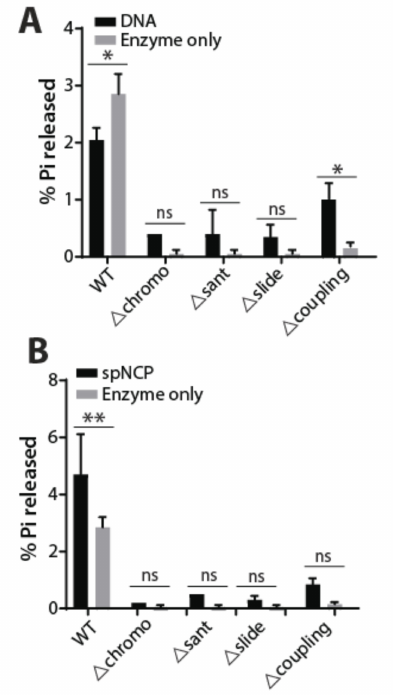
Figure 3. ATPase activities for wild type and Hrp3 mutants with DNA and nucleosome substrates: WT or mutant Hrp3 (30 femto moles) were used for ATP hydrolysis with DNA ( A ) or S. pombe nucleosomes ( B ). The y -axis shows the percentage of inorganic phosphate (Pi) released upon ATP hydrolysis by WT or mutant Hrp3. Graphpad Prism was used to plot the graphs and to calculate the significance of the catalytic activity using 2way ANOVA. For comparison between DNA-enzyme alone for WT and ∆ coupling region are 0.018 and 0.0118, respectively, while for spNCP-enzyme alone the significance value was 0.0068. The significance was calculated from two biological replicates. Other comparisons did not give significance and are marked as ‘ns’. The significance is indicated in the figure (* p < 0.05; ** p <